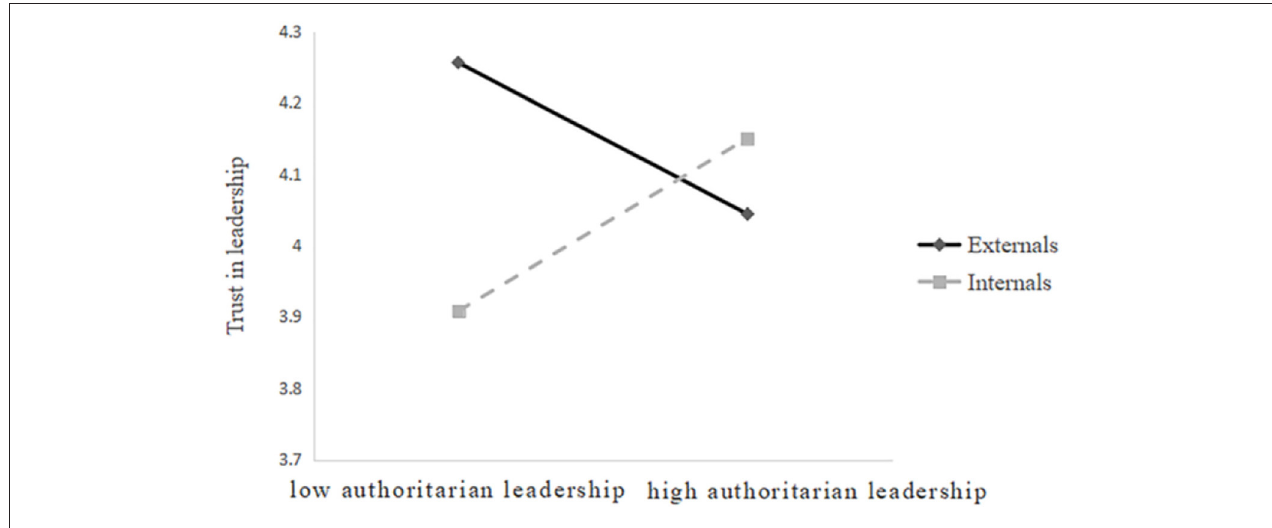
FIGURE 2 | Moderating effects of locus of control on the relationship between authoritarian leadership and trust in